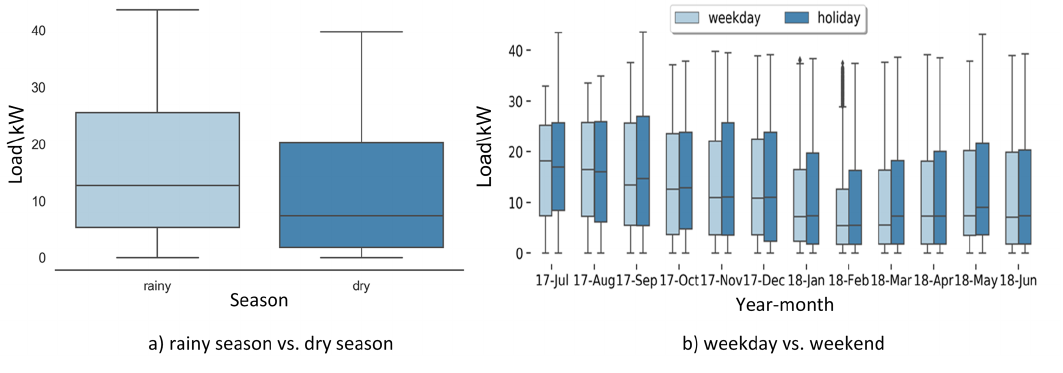
Figure 7. Box plot of EV charging